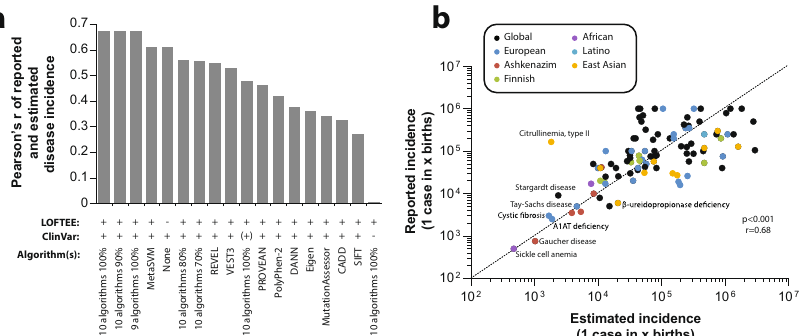
Fig. 2 Disease prevalence predicted on population-scale genomic data closely corresponds to clinically reported disease frequencies. a Comparison of predictive performance of different prediction methods for 85 AR diseases. Note that integration of database information with stringent missense and nonsense predictions was overall most accurate, resulting in highly correlated predicted and reported disease incidence (Pearson ’ s r = 0.68; p < 0.0001). Note that when ClinVar annotations are not considered and disease incidence is purely calculated on the basis of computational pathogenicity assessments, the performance of the respective prediction model is very poor ( r < 0.01). When only those pathogenic ClinVar variants are considered that are also estimated to be pathogenic using ten algorithms (indicated by “ ClinVar ( + ) ” ), performance is strongly reduced ( r = 0.48). b Detailed correlation of estimated and reported population-speci fi c or global disease prevalence using the best performing prediction model from a ClinVar + ten algorithms +